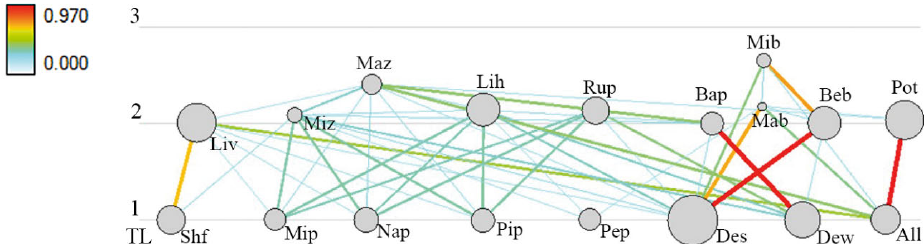
Fig. 1. Ecopath outputs based on the food web conceptualization of the 4-species polyculture ecosystem. The thickness and color of the lines illustrate the magnitude of the flow rates; the color key (dimensionless) represents the proportion that the prey con - tributed to a predator’s diet. Circle sizes are proportional to logarithm of biomass. TL: trophic level; group abbreviations as in Table 1